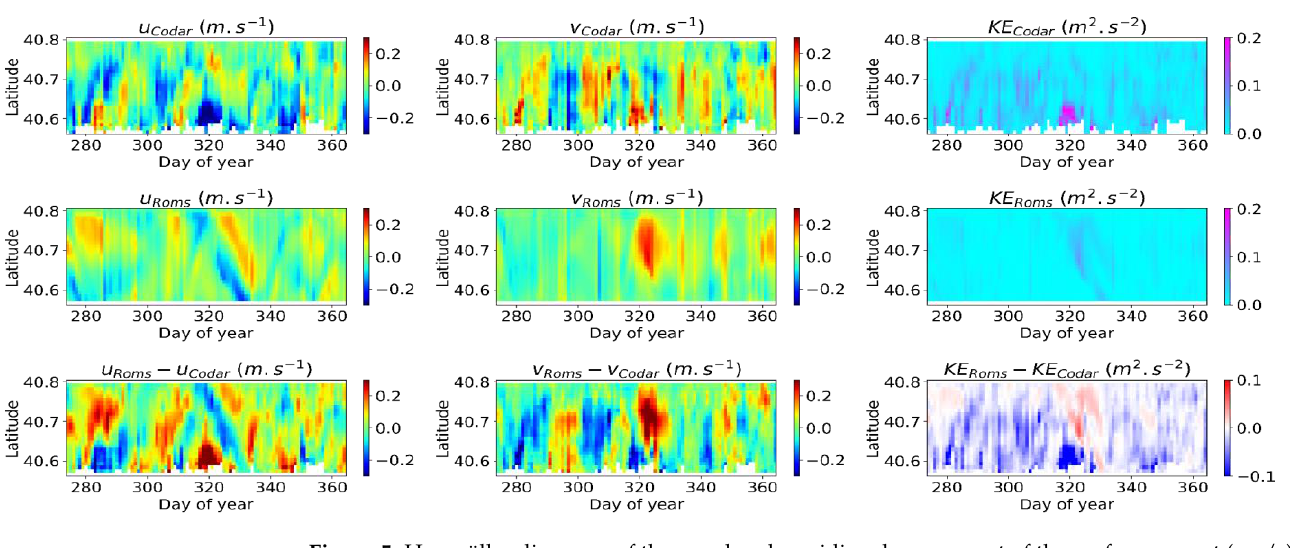
Figure 5. Hovmöller diagrams of the zonal and meridional component of the surface current (cm/s) and kinetic energy measured by the HFR and obtained from model simulation over the transect for the quarter OND in 2009.